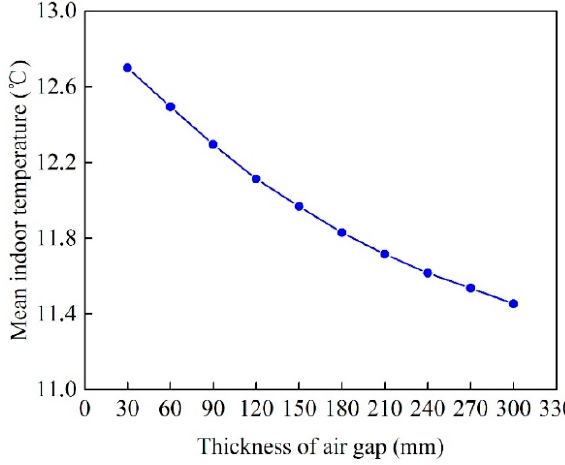
Figure 19. Mean indoor air temperature under various thicknesses of air gap.